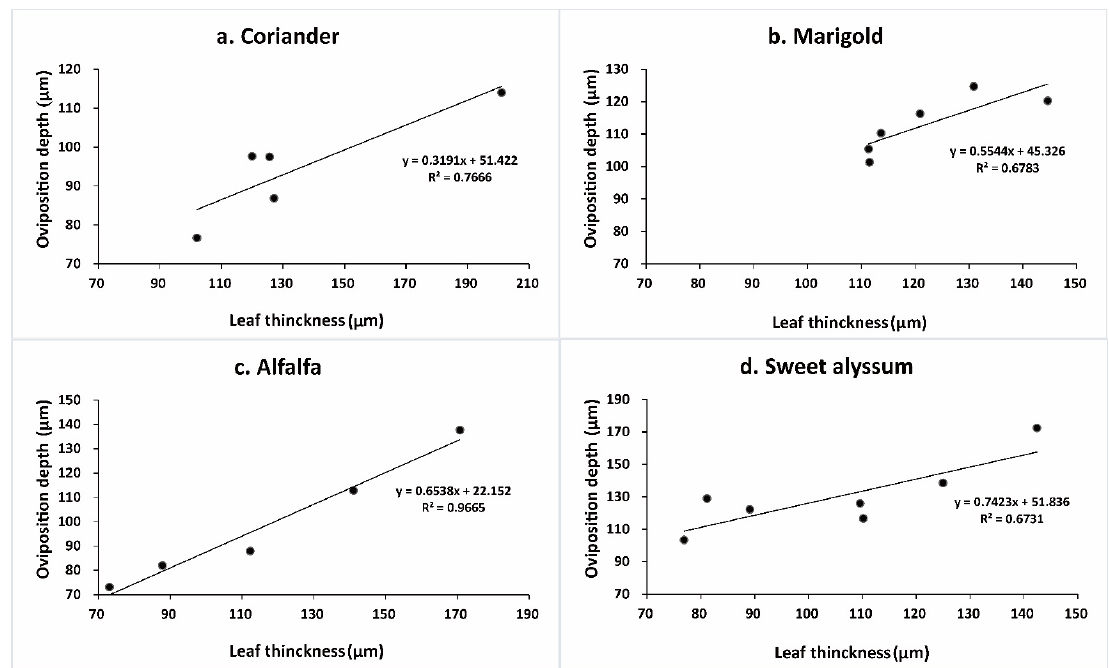
Figure 8. A comparison of the thickness of leaf-blade cross-sections among different plant species ( n = 5–7), indicating significant differences ( α = 0.05; ANOVA). Values are mean ± SE. Means indi- cated by the same letter are not significantly different according to LSD test.